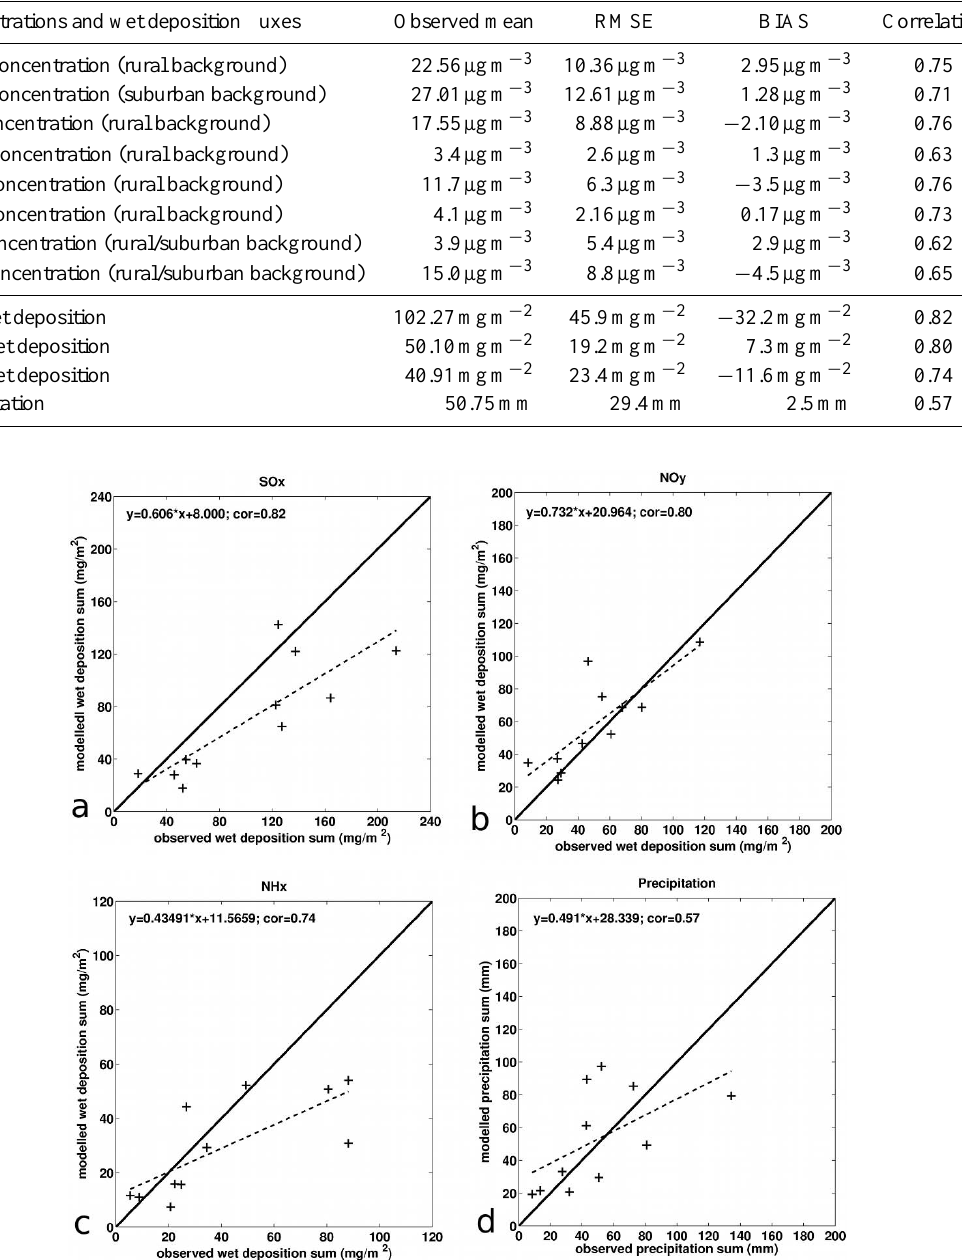
Table 4. Statistical comparison between measured and modelled concentrations and wet deposition fluxes at different stations (see Fig. 3) for the investigation period. Observed mean, as well as BIAS, RMSE and correlation are given.